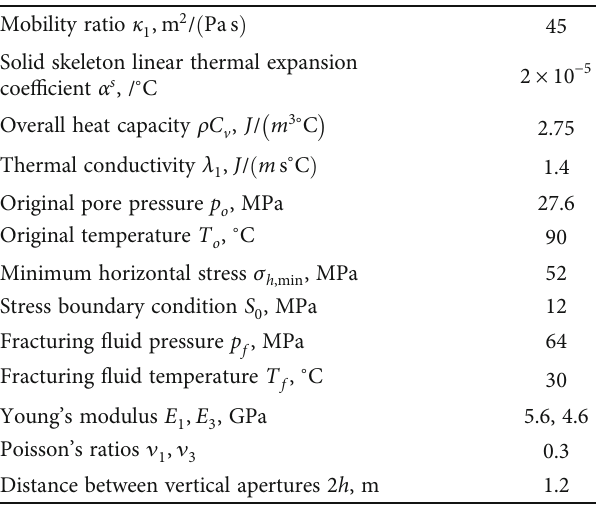
Figure 5: Monte-Carlo population simulation for Young ’ s modulus with N population = 15,000 with an average of 8.21 (GPa) and a standard deviation of 1.2 (GPa) assuming a normal distribution. Table 2: Woodford shale data used to test the sensitivity of the model to the input uncertainties.